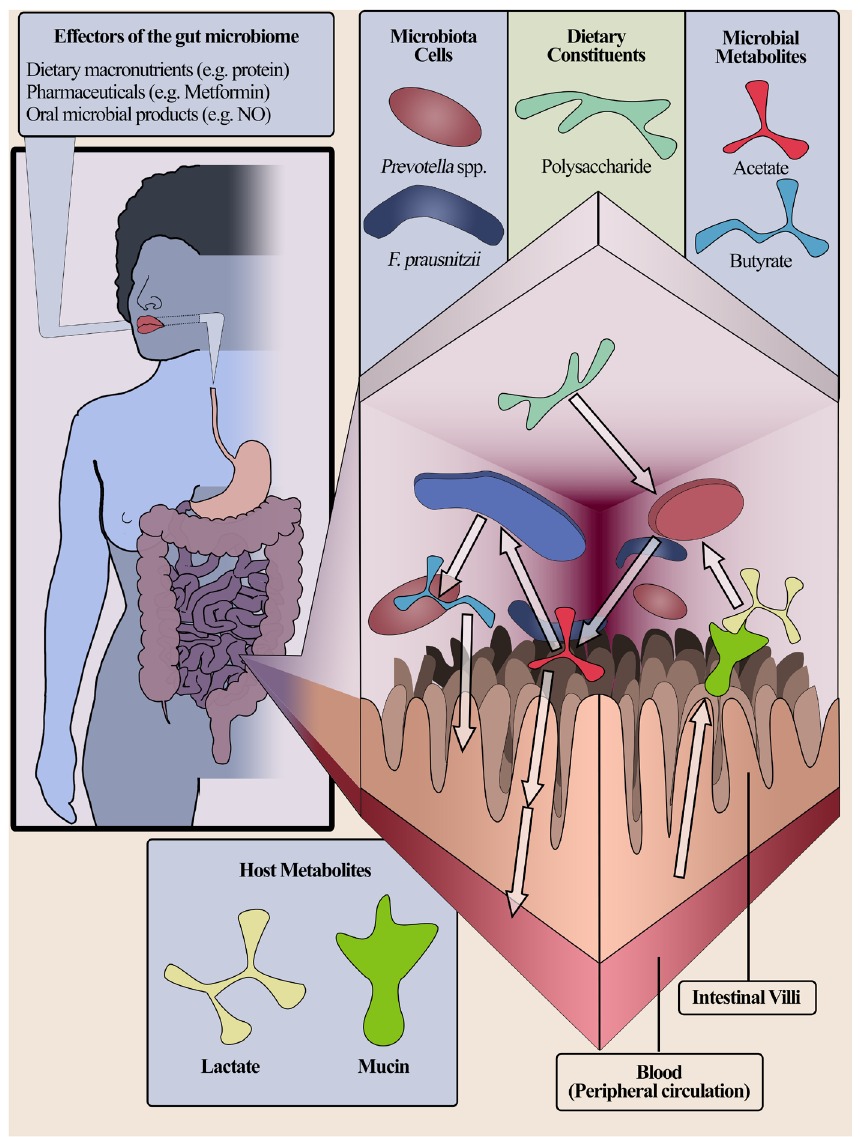
Figure 2. Host–microbe metabolic interaction. A simplified demonstration of the metabolic interactions between host and microbiome. The cross-section of the small intestine illustrates the metabolic exchange between the intestine and two taxonomic representatives ( Prevotella spp. and Faecalibacterium prausnitzii ). Polysaccharides act as an example of dietary substrate used by the microbiota for the production of short-chain fatty acid (butyrate and acetate). Similarly, host-derived substrate in the form of lactate presented with excretion of mucin from the intestine can be used by the microbiota. Within the example, acetate can be either absorbed by the intestine and subsequently the bloodstream where systematic influences take place or converted to butyrate, exerting a localised effect on intestinal epithelial cells. NO, nitric